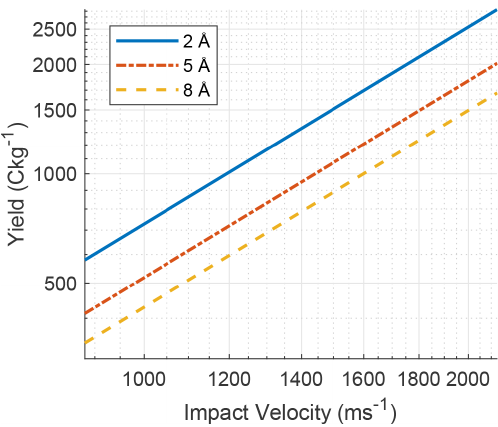
Figure 3. Sensitivity of contact charge generation in an Fe-on-Ag collision to different values of the lowest allowed fragment sizes. Cut-off values are labelled in the